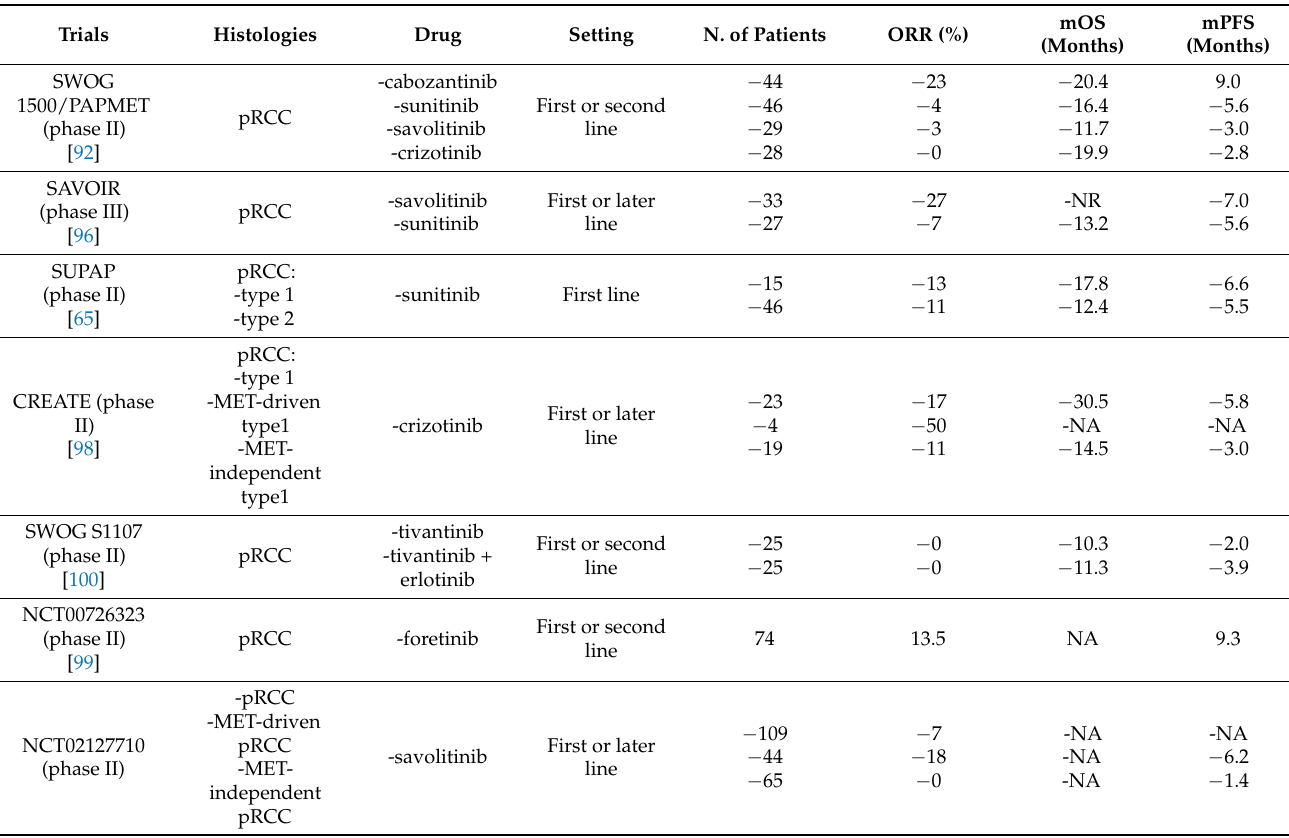
Table 2. Tyrosine kinase inhibitors assessed in pRCC: recent published